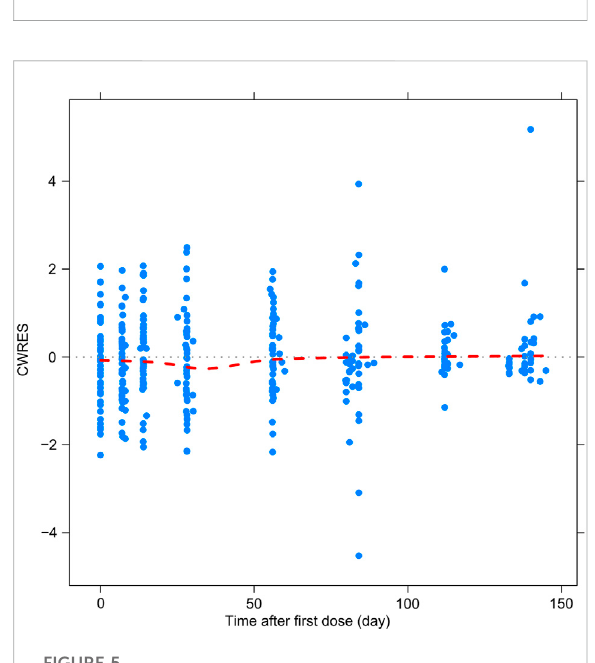
FIGURE 5 Goodness-of- fi t plots for the fi nal population PK/PD model. CWRES vs. time after fi rst